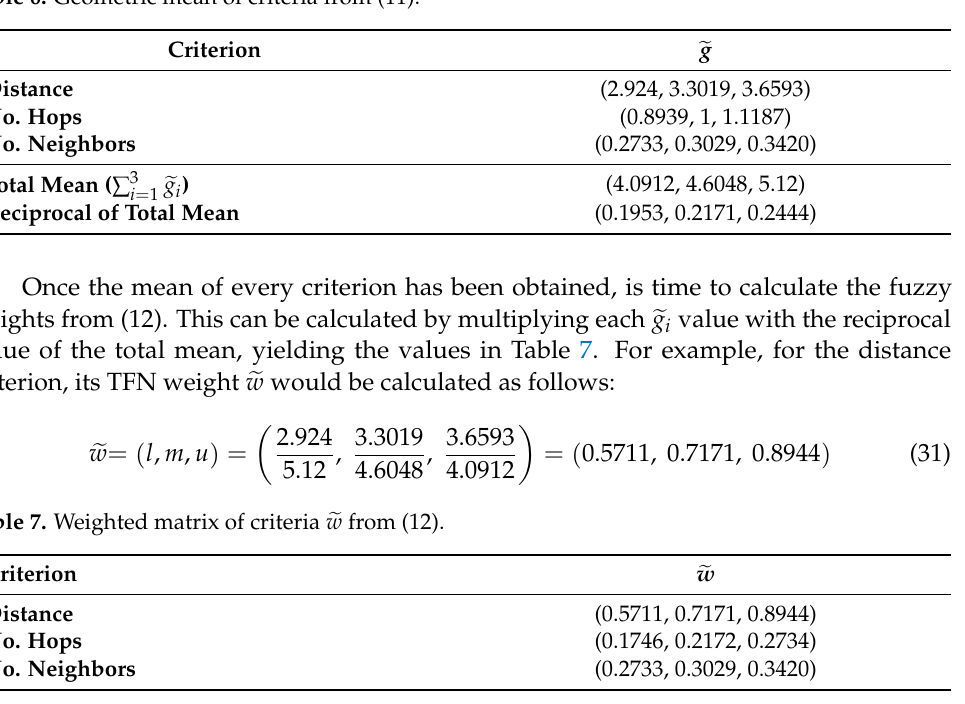
Table 6. Geometric mean of criteria from (11).